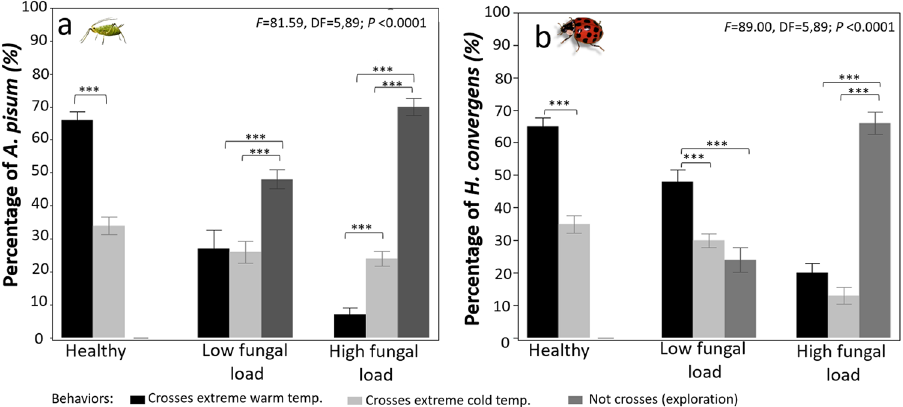
Figure 2. Thermal boldness of healthy and infected aphid and predator beetle species, measured as the number of individuals in a sample that voluntarily crossed through extreme thermal zones (ETZs, cold or warm). Infections: Low fungal load = 1.4 × 10 6 spores ha −1 , high fungal load = 1.4 × 10 12 spores ha −1 . ( a ) Aphids ( A. pisum ). ( b ) Predator beetles ( H. convergens ). Warm and cold ETZs for A. pisum were set at 48 °C and − 4 °C, whereas for H. convergens thermal barriers were set at 56 °C and − 12 °C. Two–way ANOVA. Bars represent